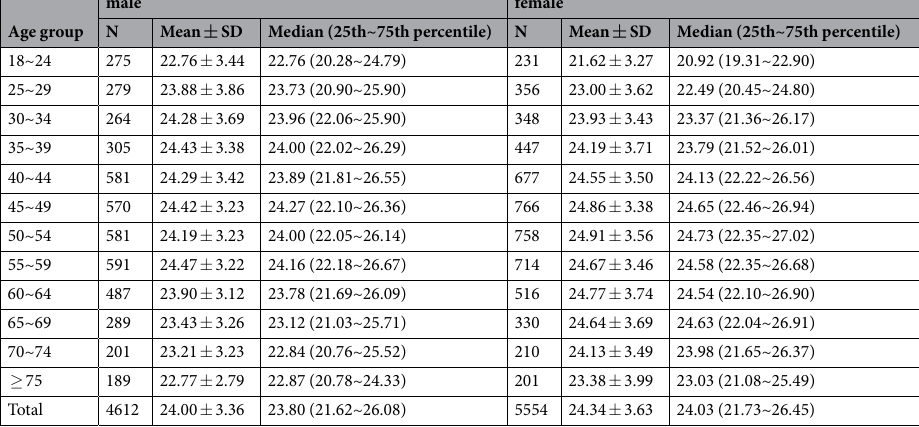
Table 2. BMI prevalence in northwest China by age and sex. Abbreviations: BMI, body mass index; SD, standard deviation.